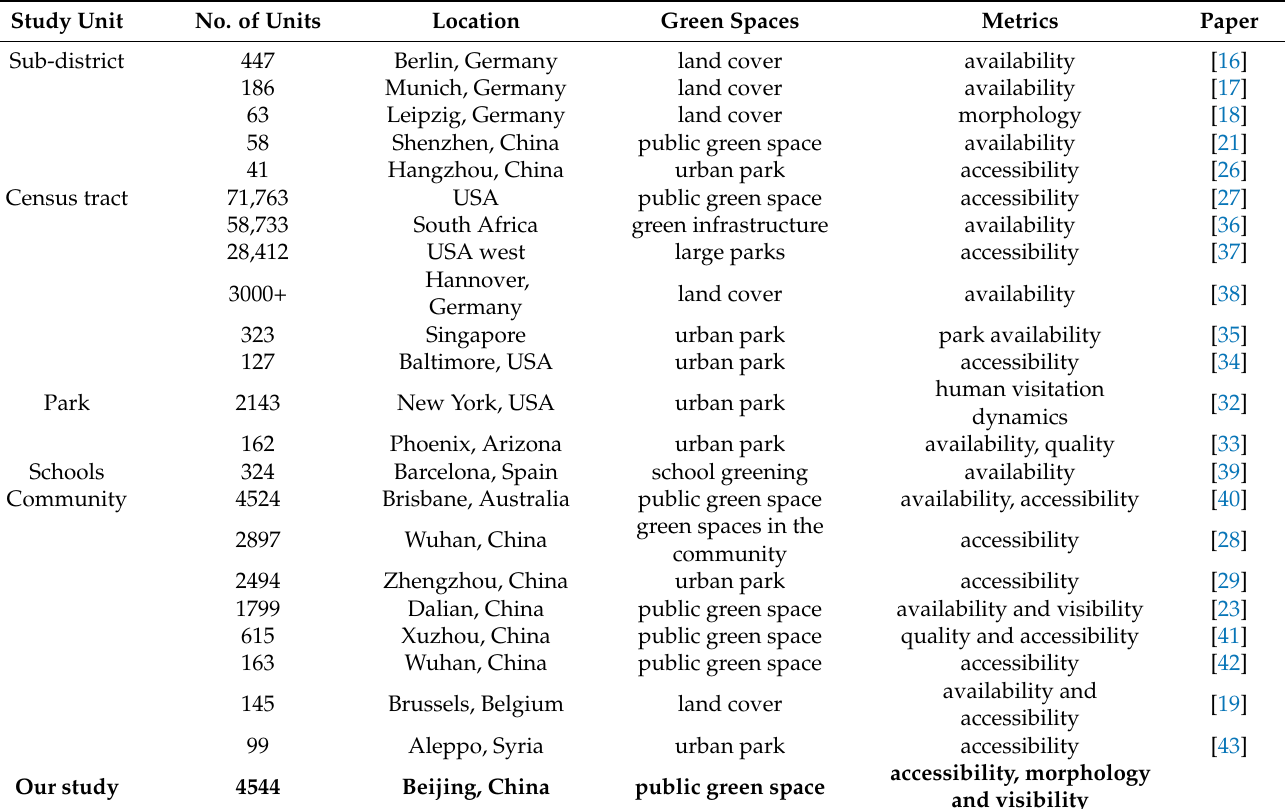
Table 1. A comparison between representative studies of community green space equity and our study. Study